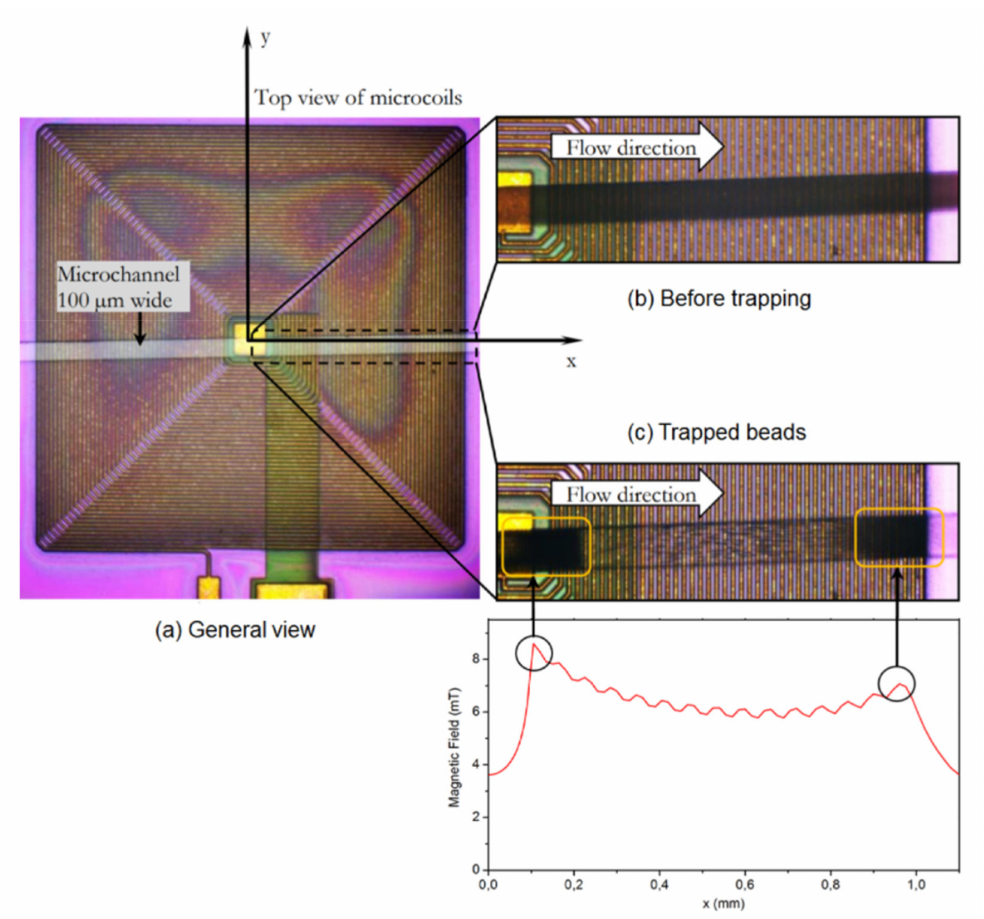
Figure 8. Magnetic nanoparticles trapped by micro-coils in a microfluidic device are illustrated. ( a ) The whole chip. ( b ) Injection of particles. ( c ) Beads trapped with coils. Reprinted with permission from O. Lefebvre, et al., 2020 Micromachines 11(3), 257 [96] under the terms and conditions of the Creative Commons Attribution (CC BY) license http://creativecommons. org/licenses/by/4.0/, accessed on 28 June 2021. Copyright 2020